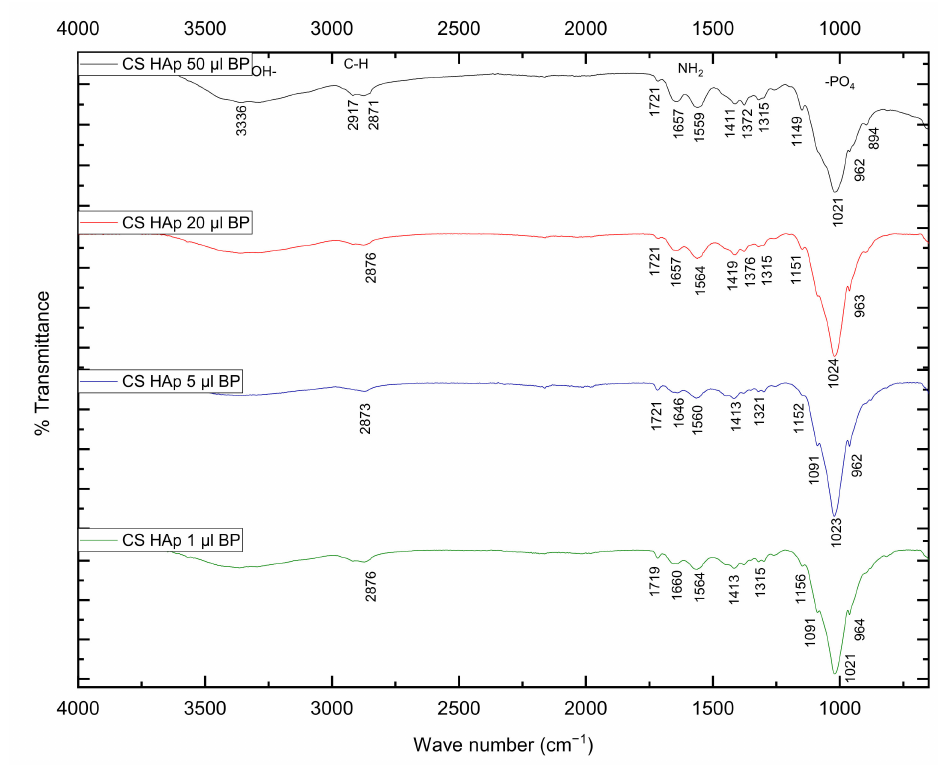
Figure 4. FTIR spectrum of CS/HAp scaffolds incorporating 50, 20, 5 and 1 µ L BP at 0.1% w/v